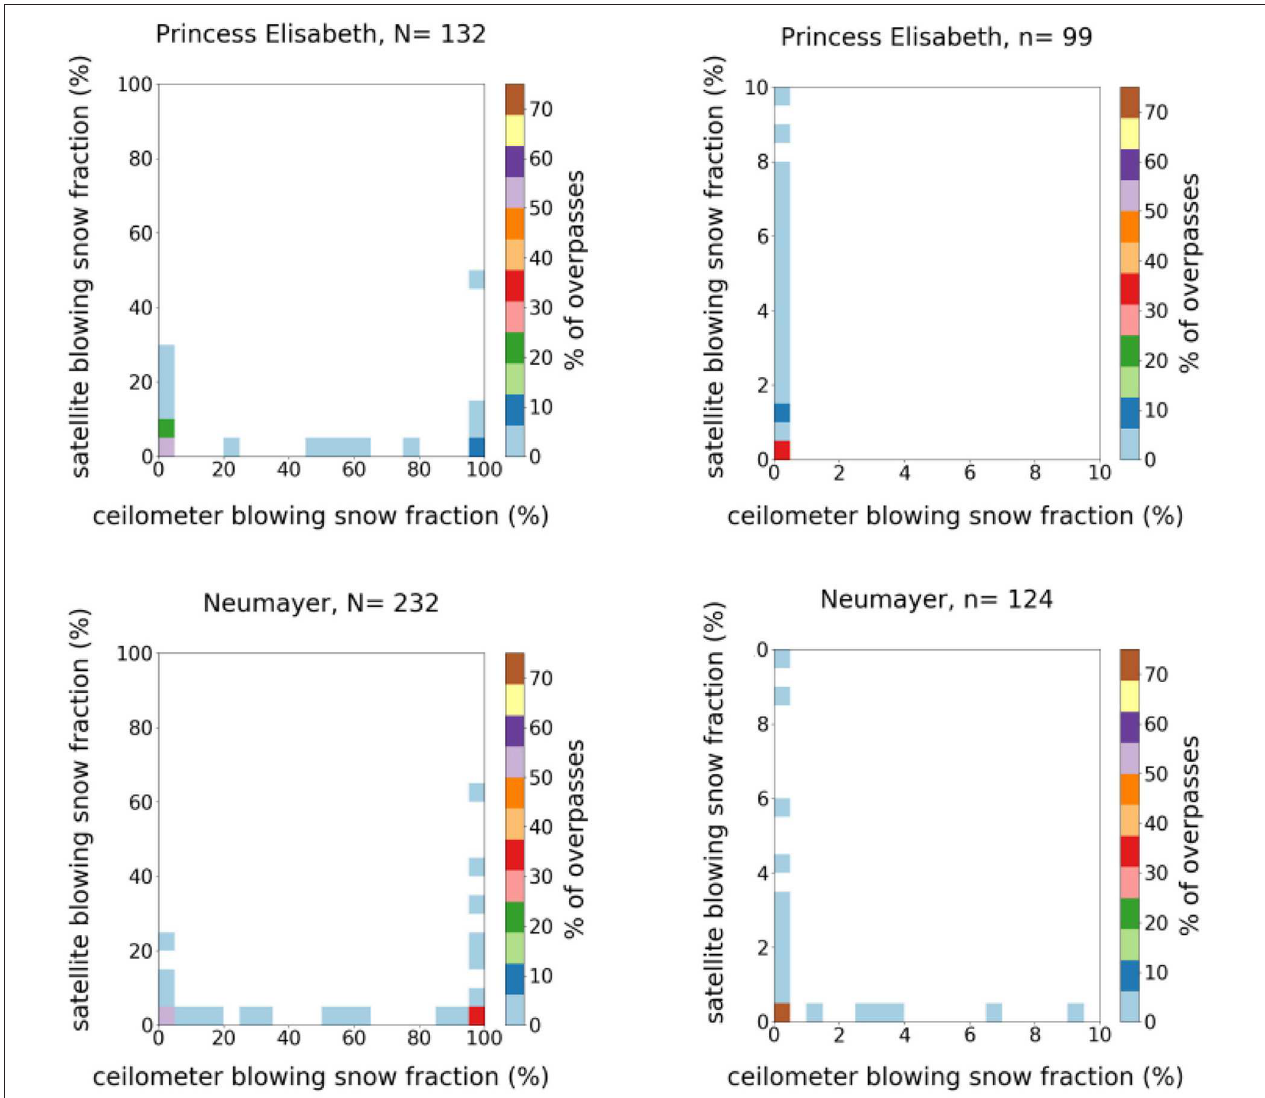
FIGURE 4 | Concurrent measurements of blowing snow fraction at top Princess Elisabeth and bottom Neumayer stations, as derived from the ceilometer signal (x-axis) and the satellite return (y-axis). The detections include all-sky measurements for the ceilometer and clear-sky only for the satellite. The right graph is a zoom between 0 and 10 % for both detection methods.